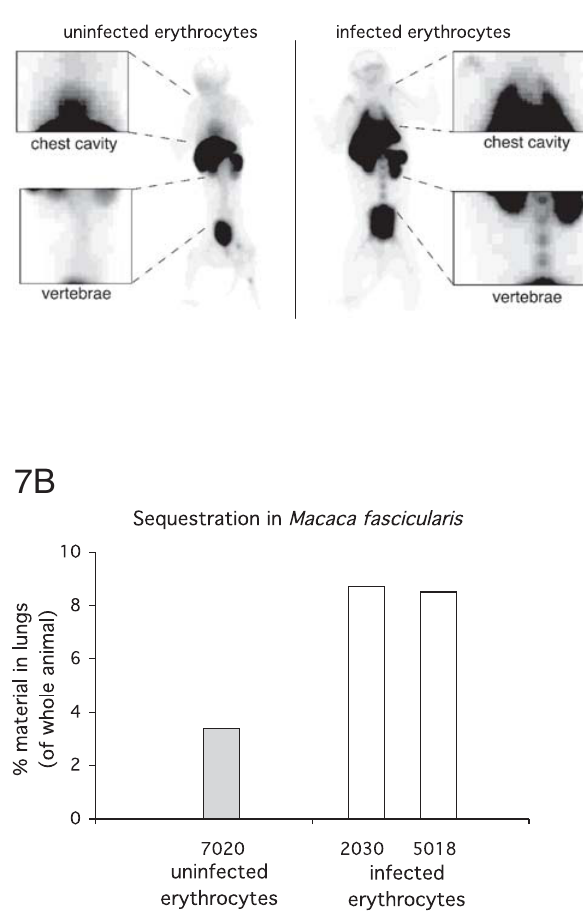
Figure 7. Sequestration of P. falciparum IE of Parasite FCR3S1.2 in Macaca fascicularis Monkeys were injected with 99m Tc-labeled IE of FCR3S1.2 or with 99m Tc- labeled uninfected human erythrocytes and left for 60 min followed by analysis in an X-ray–equipped triple-headed gamma camera (ID 7020, uninfected erythrocytes; ID 2030 and 5018, IE). (A) Shows the whole-body summary images captured 60–75 min after the injection of the 99m Tc-labeled cells. Amplified areas show the chest cavities and the vertebrae. The accumulation of 99m Tc-labeled IE in the lungs and in the bone marrow suggests their specific sequestration. The activity in the heart of the animal that received uninfected erythrocytes indicates that the erythrocytes are in circulation. (B) Shows the relative amount of material in the lungs as compared with the activity of the whole animal and measured for 15 min (60 to 75 min after injection). White bars show results of individual monkeys injected with IE, whereas the grey bars show the results of the control animal injected with uninfected human erythrocytes. DOI: 10.1371/journal.ppat.0020100.g007